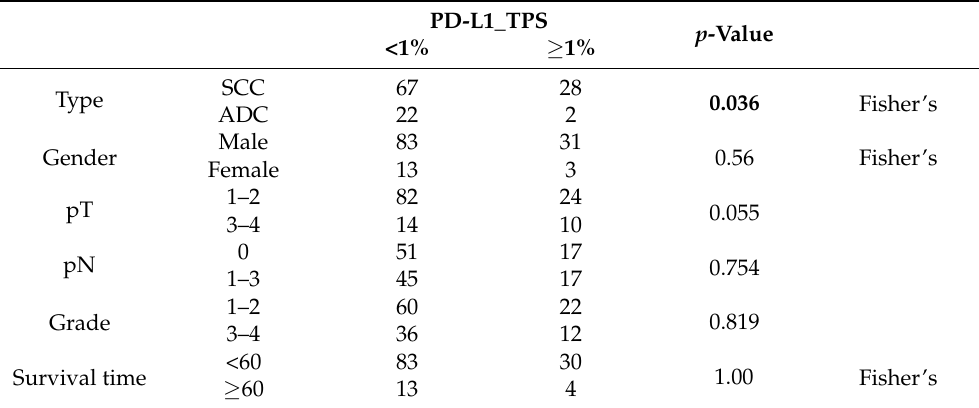
p -Value 0.036 Fisher’s 0.56 Fisher’s